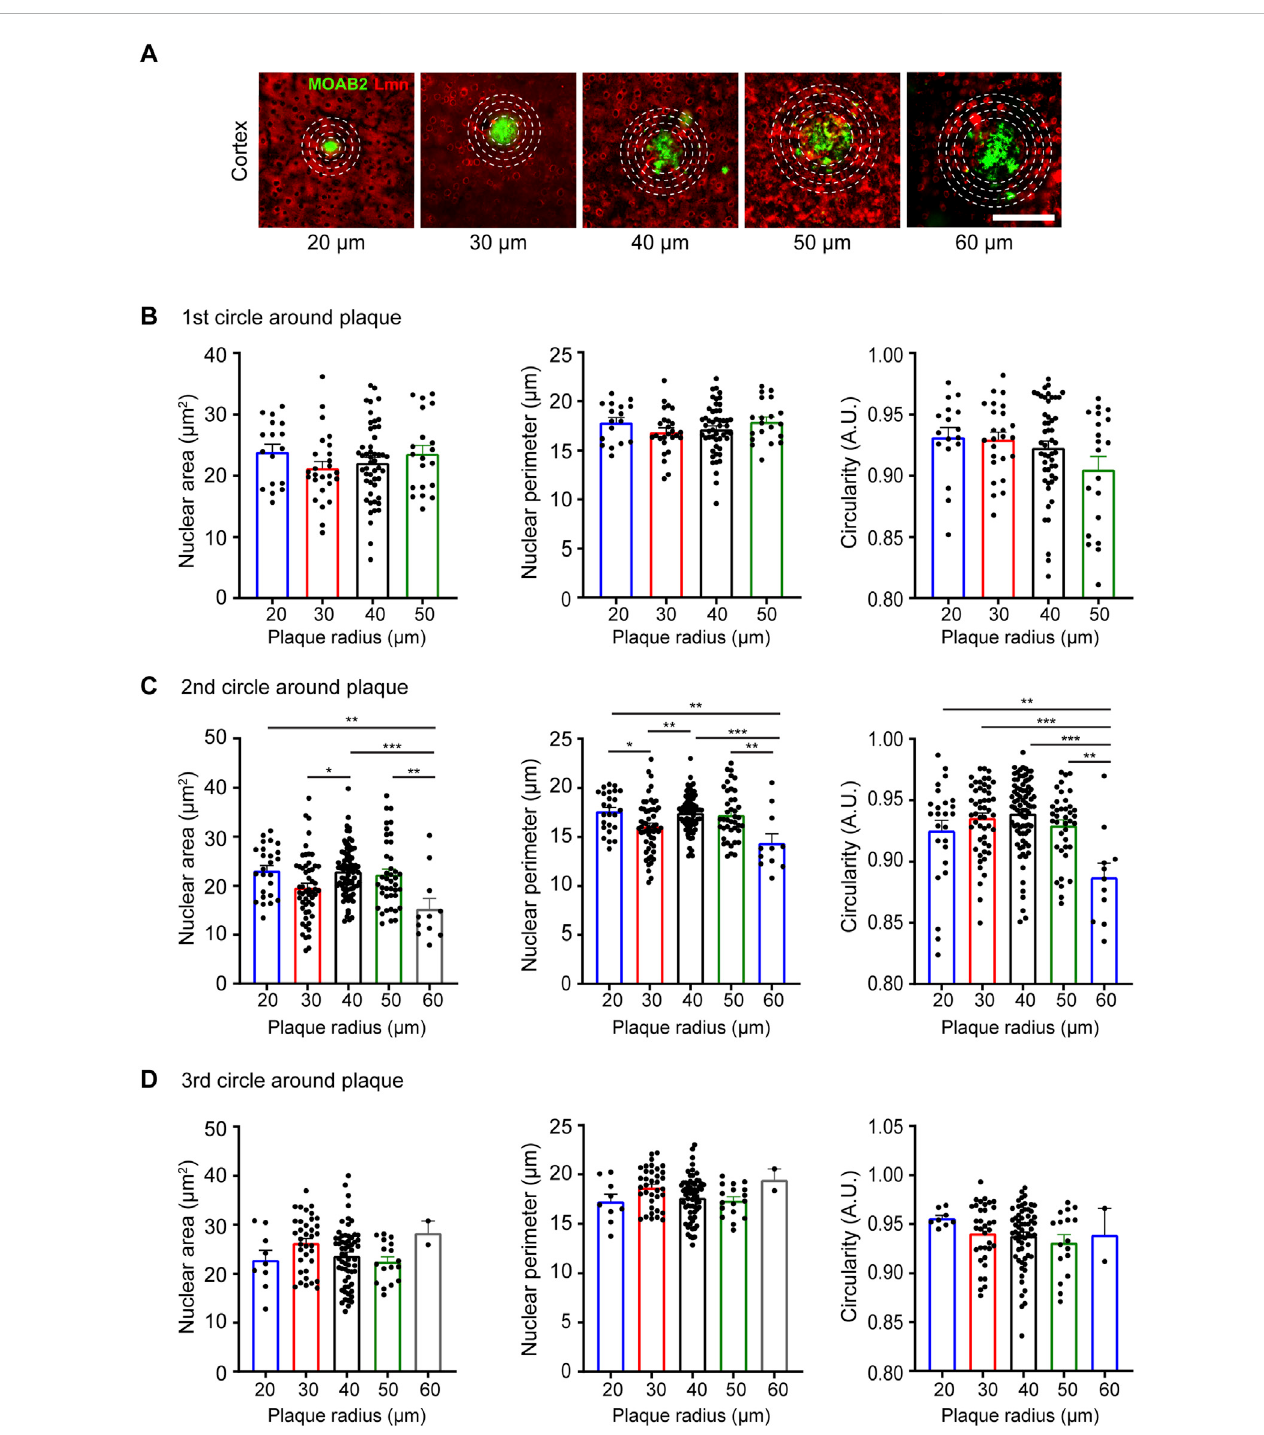
FIGURE 5 Neuronal nuclear morphology around plaques in the APP/PS1 transgenic mice at 6 months of age. (A) Immunostaining using anti-NeuN (blue), anti- MOAB2 (green; stainsplaques) and anti-Lmn(red).Scalebar, 30 µm. (B – D) Meannuclear area,perimeter,andcircularityat20 µmradius (B) ,40 µmradius (C) and 60 µm radius (D) from plaques of different sizes. Neuronal nuclei morphology characterized for the following plaque radii: 20, 30, 40, 50, and 60 μ m n = 3 mice. One-Way ANOVA (* p < 0.05, ** p < 0.01, *** p < 0.001 and **** p < 0.0001). Data represented as mean ±